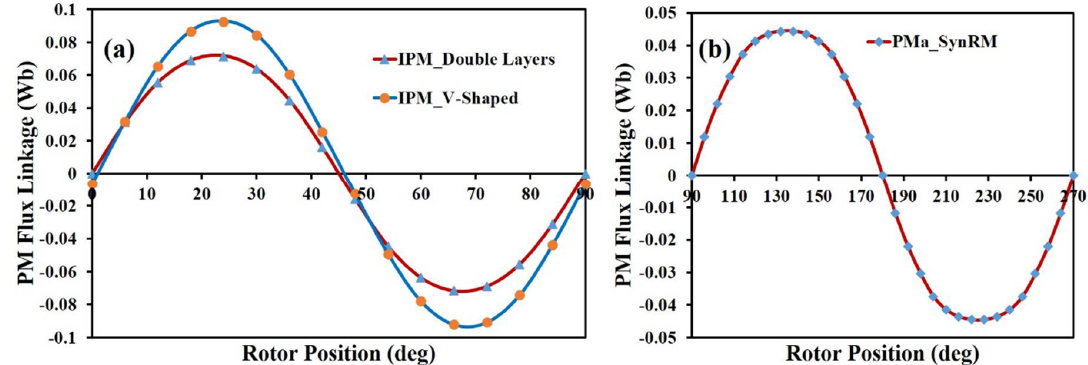
Figure 4. Comparison of PM flux linkage of IPMSM and PMa-SynRM: ( a ) IPMSM and ( b ) PMa-SynRM. Reference angle starts from q -axis.